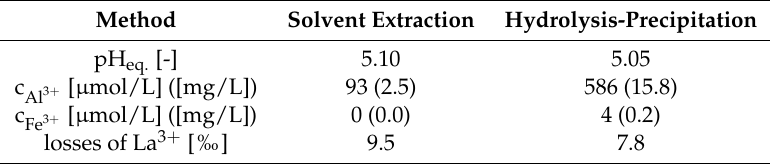
Figure 9. Removal of aluminum and iron from ternary-component solutions ( a ) by solvent extraction (experiment (5) ) and ( b ) by hydrolysis-precipitation. Table 6. Comparison of purity of the raffinate and the losses of